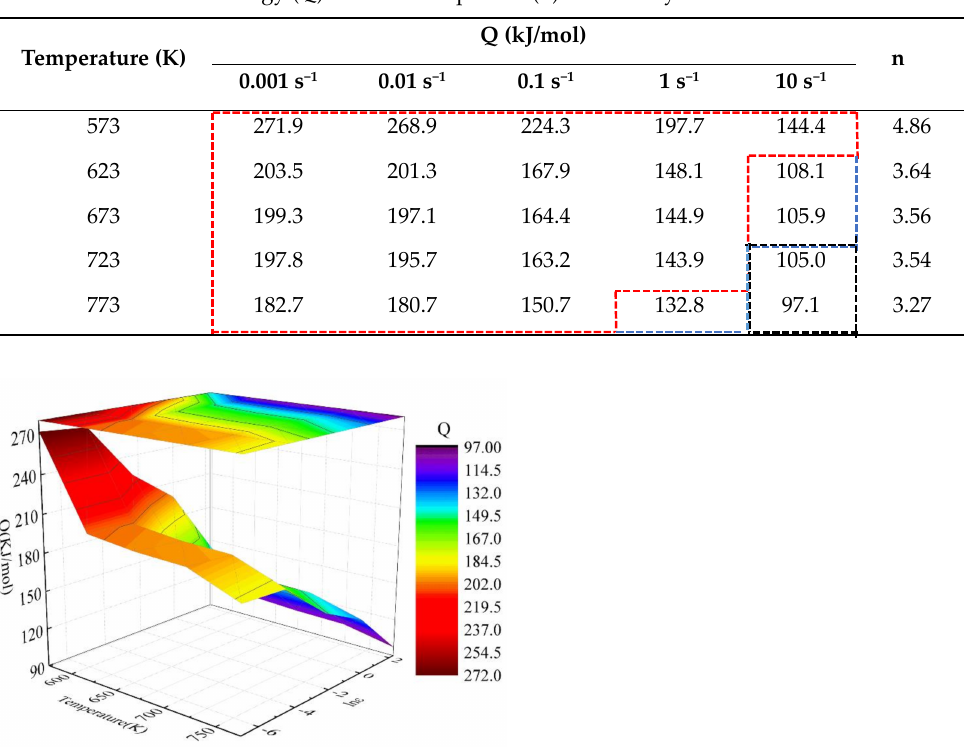
Table 3. The activation energy (Q) and stress exponent (n) of the alloy at a strain of 0.4.